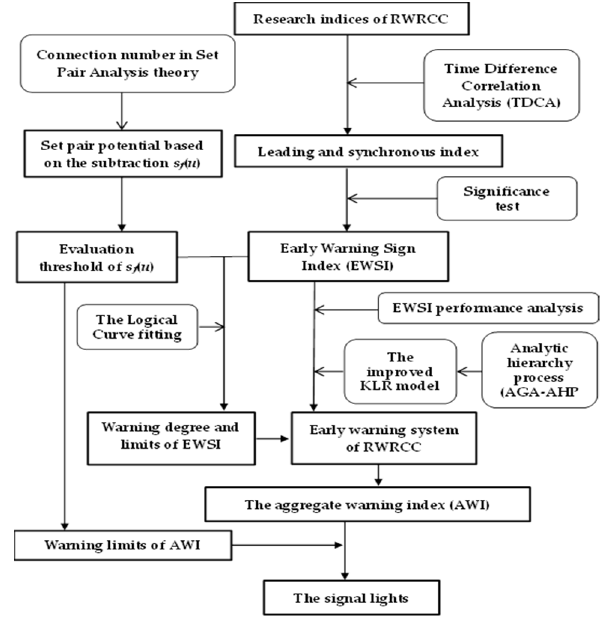
Figure 1. Process of early warning method of regional water resources carrying capacity.